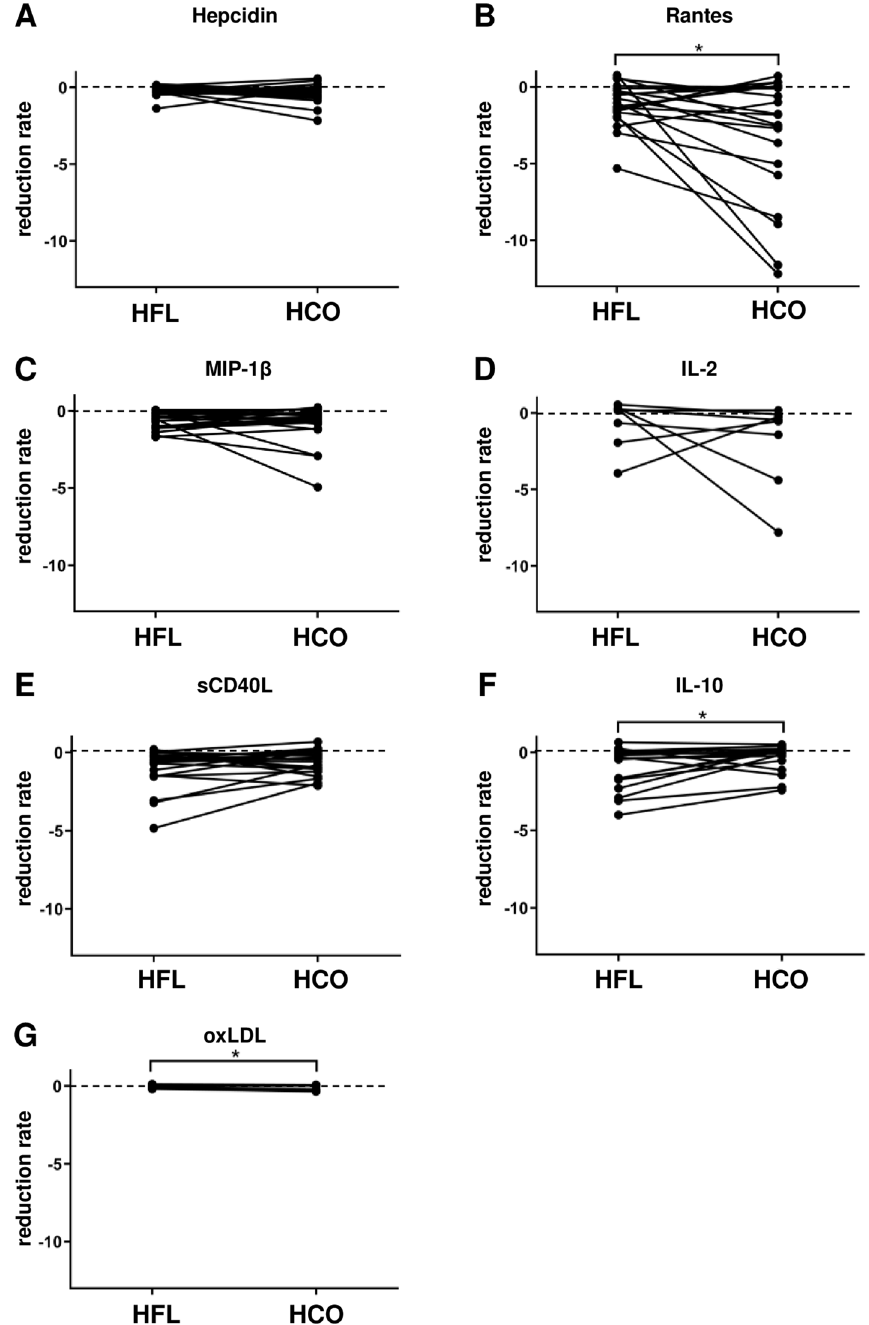
calculated as 1-(concentration post-dialysis/concentration pre-dialysis). ( A ) Hepcidin, n = 19; ( B ) RANTES, n = 19; ( C ) MIP1b, n = 19; ( D ) IL-2, n = 8; ( E ) sCD40L n = 19; ( F ) IL-10, n = 17; ( G ) oxLDL, n = 9. * P <